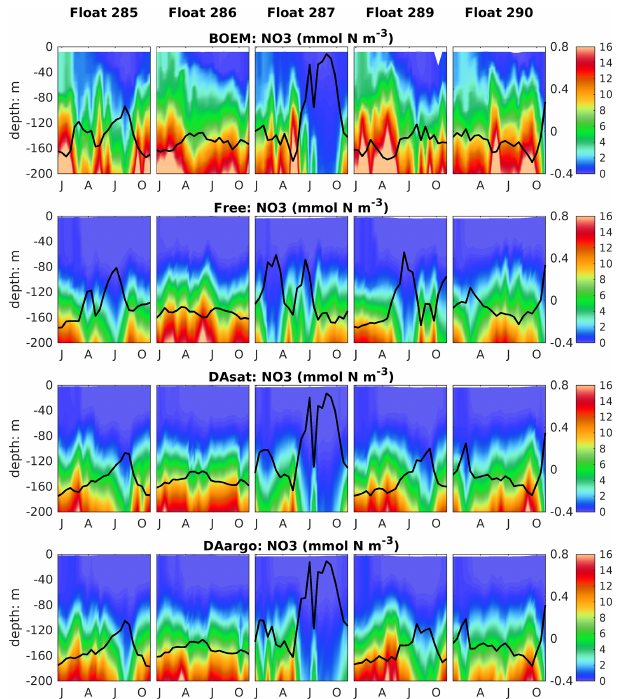
Figure 7. Vertical distributions of nitrate, which are estimated based on its climatological relationship with temperature and modeled by different experiments, superimposed with the SSH (thick black lines).